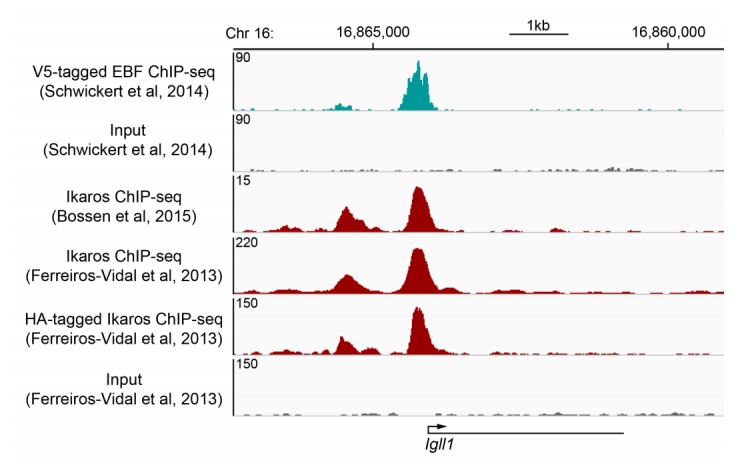
Additional support for Ikaros and EBF1 binding at the Igll1 promoter in B cell progenitors.V5 epitope tag-specific EBF1 ChIP and input (top, Schwickert et al., 2014), ChIP for endogenous Ikaros using the C-terminal Ikaros antibody employed in this study (Bossen et al., 2015; Ferreiros-Vidal et al., 2013), HA-tagged Ikaros using a HA epitope tag-specific reagent (Ferreiros-Vidal et al., 2013) and input (Ferreiros-Vidal et al., 2013) show binding of EBF1 and Ikaros to the Igll1 promoter.